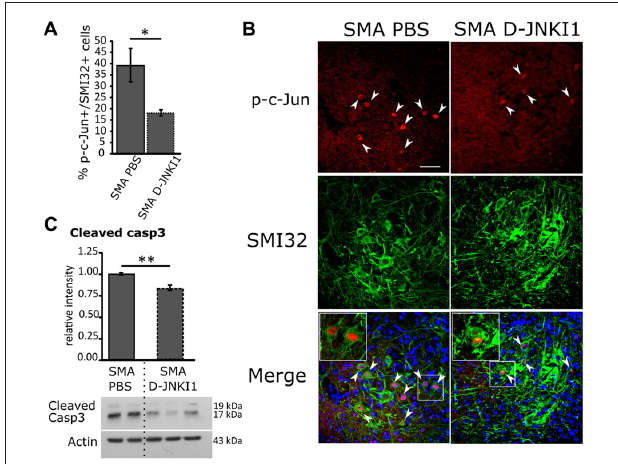
FIGURE 4 | Positive effect of D-JNKI1 treatment on MN survival in SMA mice, at P12. (A) Quantification of the percentage of MNs (SMI32+) expressing p-c-Jun between PBS- and D-JNKI1-treated SMA pups. (B) Confocal images showing p-c-Jun/SMI32-positive cells in the ventral horns of PBS- and D-JNKI1 treated SMA mice. Upper panels show p-c-Jun positive nuclei (in red), indicated by arrowheads; central panels indicate SMI32-positive MNs (in green). In lower merge panels, the colocalization of p-c-Jun and SMI32 is displayed and, in addition, cell nuclei are labeled by DAPI staining (in blue): insets show higher magnification of p-c-Jun/SMI32-double labeled MNs. (C) Western blot of the relative phosphorylation intensity of cleaved Caspase-3 in SMA-PBS and SMA D-JNKI1 pups. Unprocessed original scans of blots are shown in Supplementary Figure S1 . Scale bar 50 µ m. ∗ P < 0.05; ∗∗ P < 0.01.